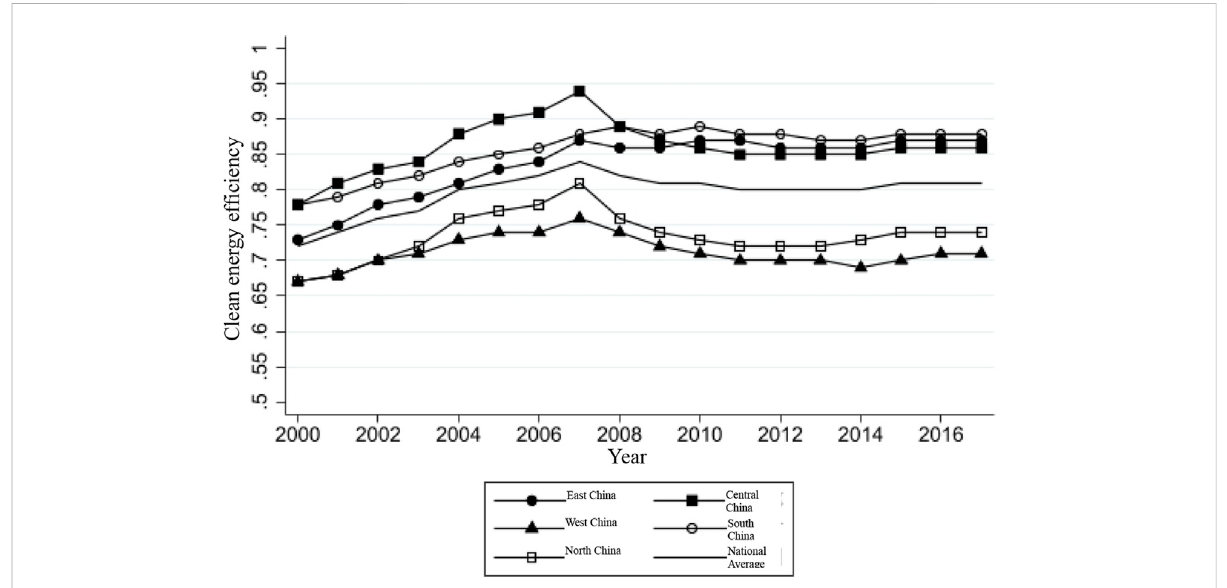
FIGURE 5 2000-2017 green and clean energy ef fi ciency structure of China (average emission